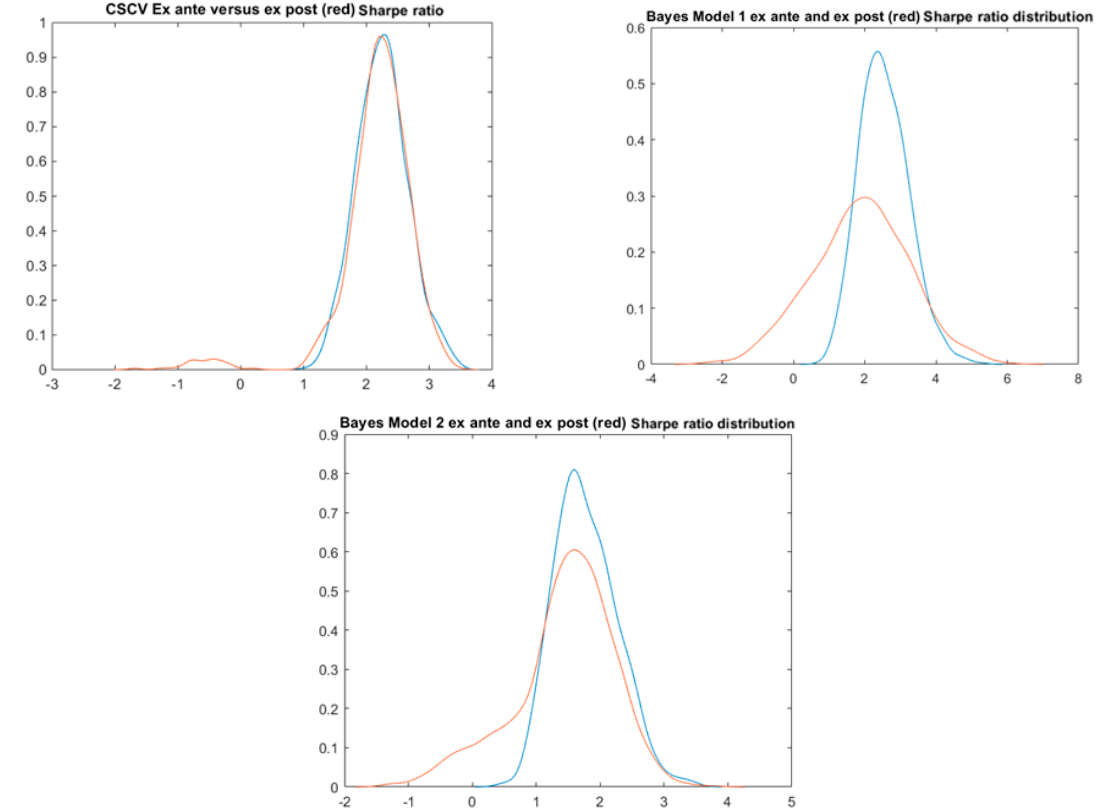
Figure 19. The simulations of the ex ante (blue) and ex post (red) SR probability densities. Lastly, we modify the returns of the strategies by deducting the observed mean re- turns (from the daily strategy returns) and adding random noise means with standard deviation 1% p.a. ( Error! Reference source not found. ). Therefore, in this case, we expect the methods to reject the existence of a positive strategy. Figure 20. The modified annualized mean returns and Sharpe ratios of the 200 strategies. All the methods, except for the Bayes Model 1, clearly refute the existence of a posi- tive strategy ( Error! Reference source not found. ). The surprisingly optimistic results of Bayes Model 1 can be again explained by the volatility incorporated into the Bayes pa- rameter MCMC estimation leading to sampling of models with higher positive means in the MC part of the simulations. The first graph in Error! Reference source not found. also clearly demonstrates the strong negative bias of the CSCV method where the best IS model